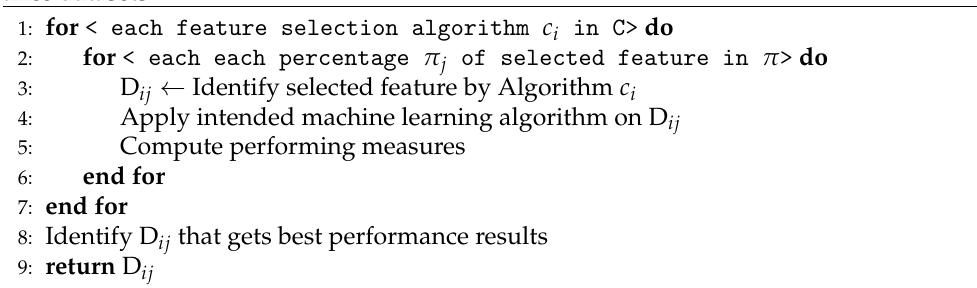
Algorithm 1 Proposed framework for identifying most influential attributes in insur- ance